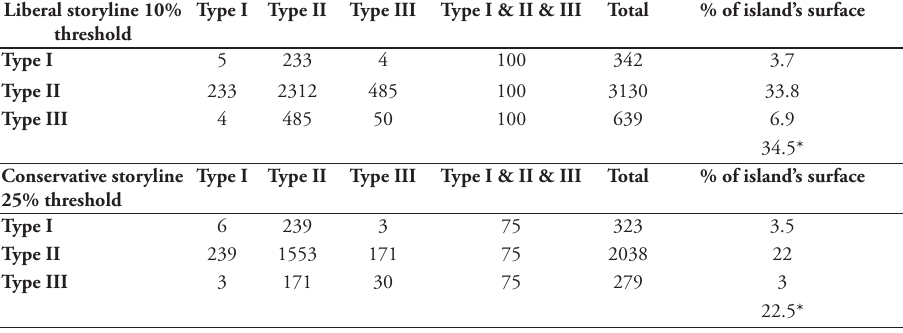
Table 2. Extent of the HNVf types in the study area (CYGCA), showing also the extent of overlap be- tween types.